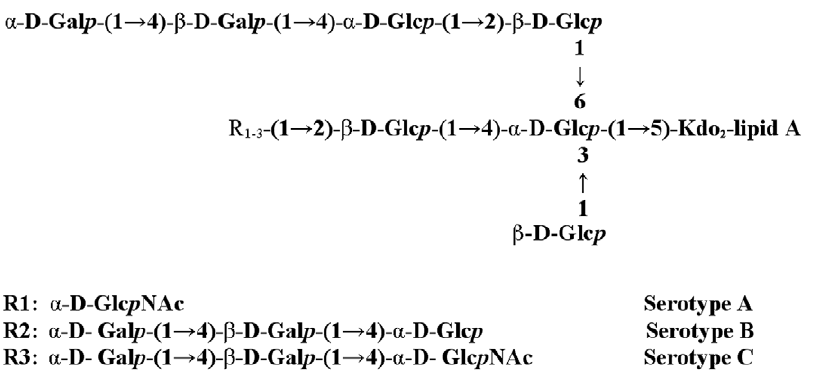
Figure 1. Schematic structures of the LOS moieties on the surface of M.catarrhalis . Three main serotypes, A, B and C, are presented with different R groups [14–16]. Abbreviations: Gal, galactose; Kdo, 3-deoxy-D-manno-octulosonic acid; Glc, glucose; GlcNAc, N -acetyl-D-glucosamine; p , pyranose.